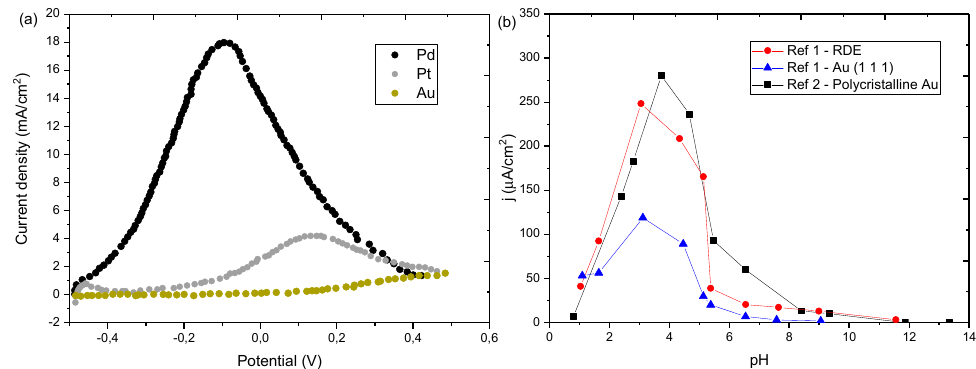
Figure 10. ( a ) CV forward scans of formic acid/formate oxidation on Pt, Pd and Au. Figure was redrawn with data taken from reference 54; ( b ) dependence of current density with pH, at 1.0 V vs. RHE, for FA oxidation on Gold electrodes. Figure was redrawn with data taken from references 58